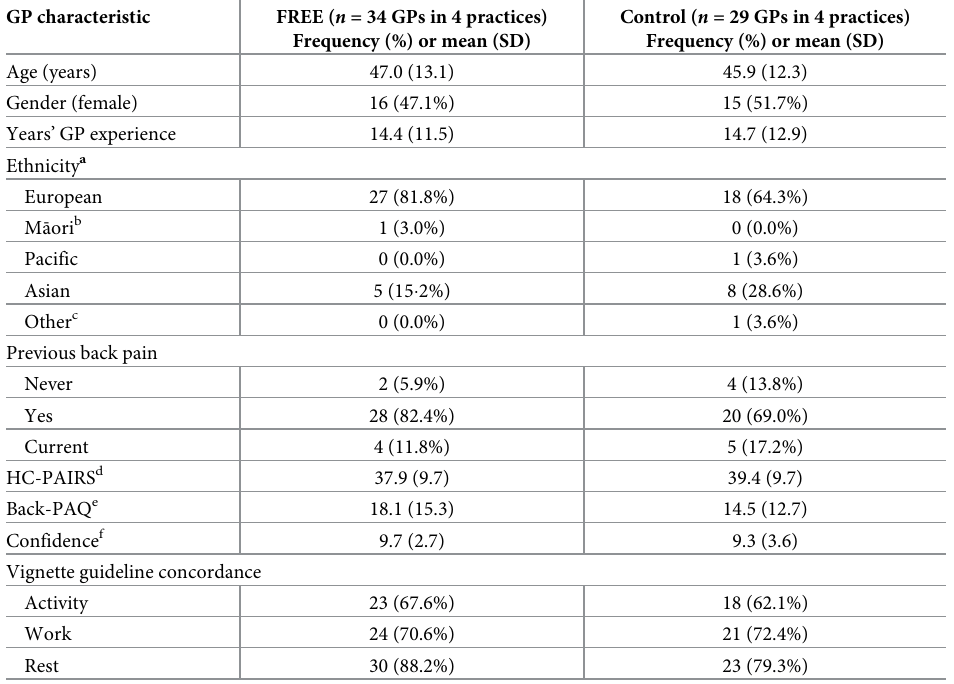
Table 1. Baseline characteristics of GP